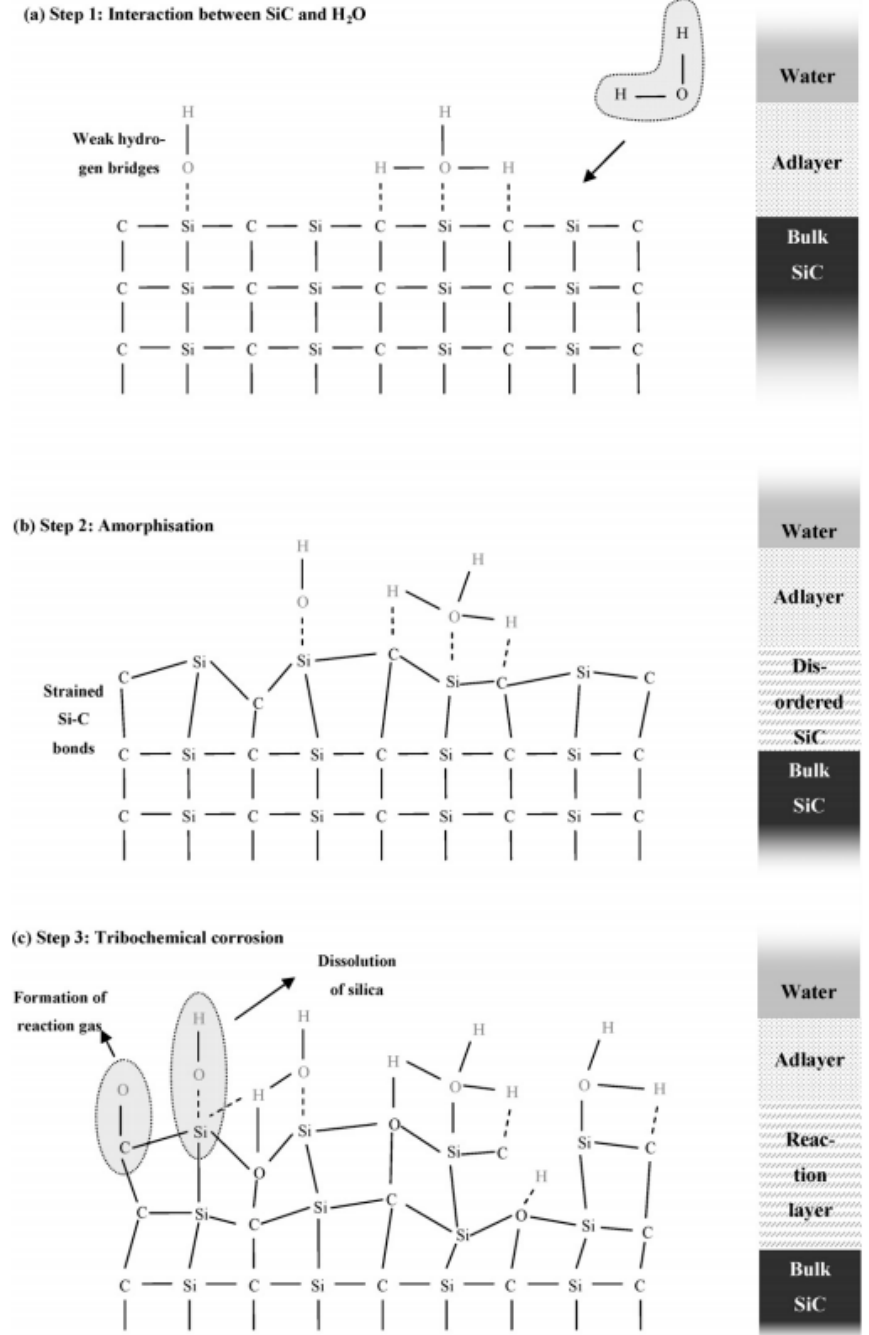
Figure 35. Three-step tribomodel of SiC corrosion. Reprinted with permission from Reference [107]. Copyright 2009 Elsevier.